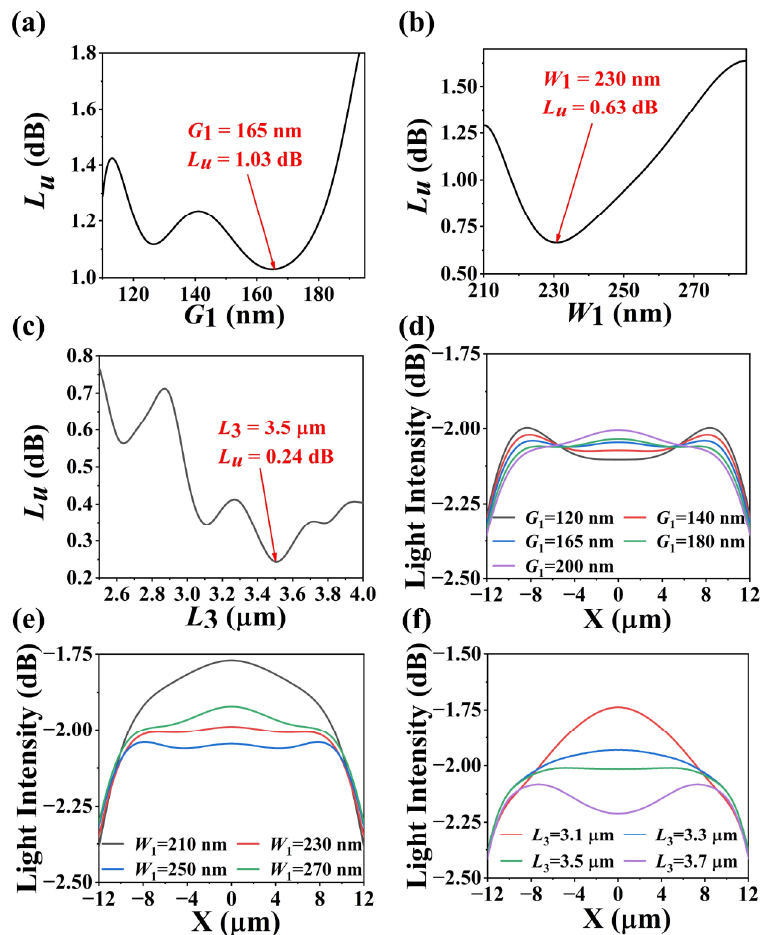
Figure 2. Simulated non-uniformity with the variation of ( a ) G 1 , ( b ) W 1 and ( c ) L 3 . Light intensity distribution along the image plane of AWG with different values of ( d ) G 1 , ( e ) W 1 and ( f ) L 3 .